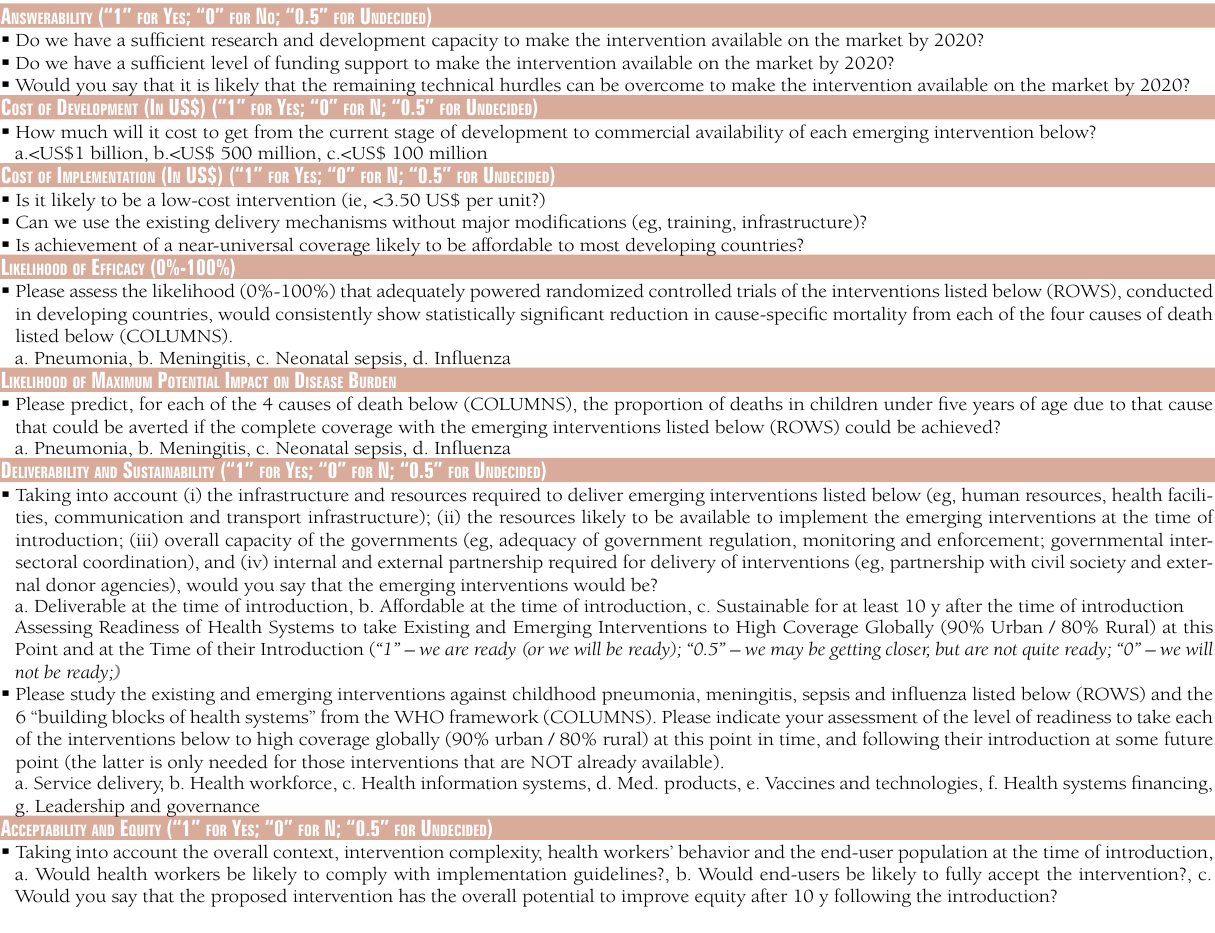
Table 2 A summarized version of questions used to assess whether proposed 29 interventions satisfy the 12 priority-setting